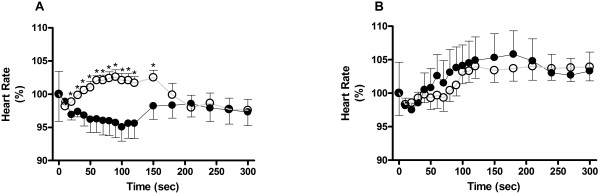
Nicotine induces a biphasic response in isolated beating-heart preparations. Nicotine at concentrations of 1 μM (left panel) and 10 μM (right panel) was perfused during 5 min. The bipolar 400 Hz acquisition rate EKG records indicated that 1 μM nicotine increased the heart rate of chagasic hearts (open circles), while decreasing it in healthy hearts (filled circles). 10 μM nicotine induced a biphasic effect (i.e., transiently bradychardia followed by sustained tachycardia) on both healthy and chagasic animals’ heart rate. * p < 0.05 indicated statistically significant difference compared to pre-drug basal rate.